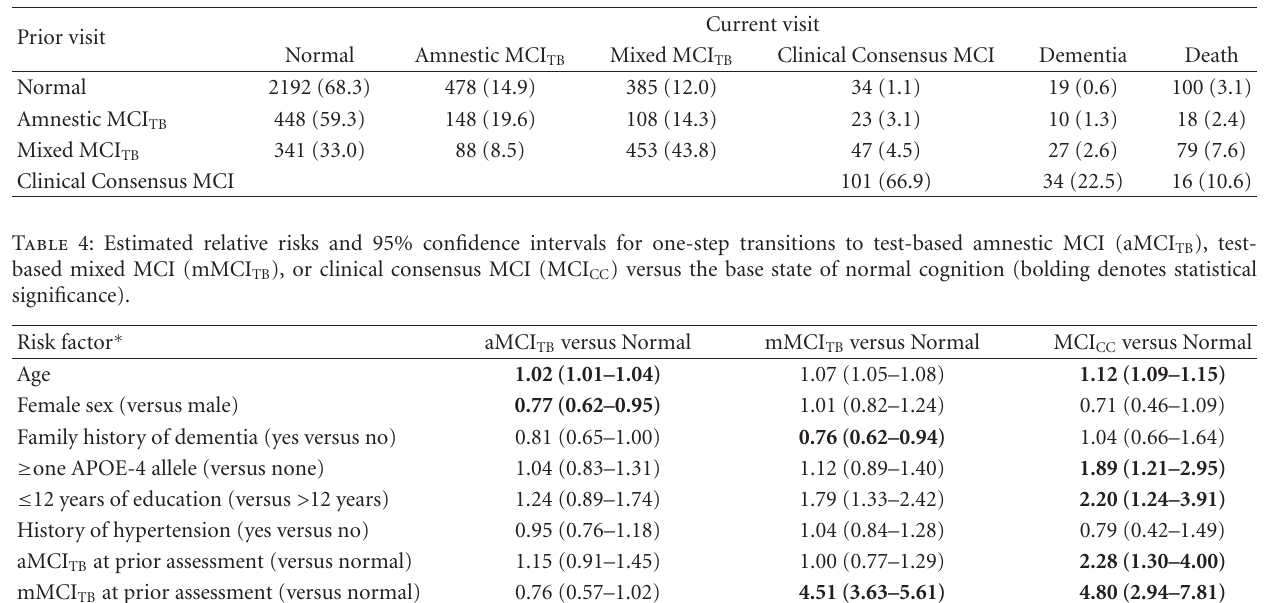
Table 3: One-step transition matrix (number of assessments [% of prior visit state]).